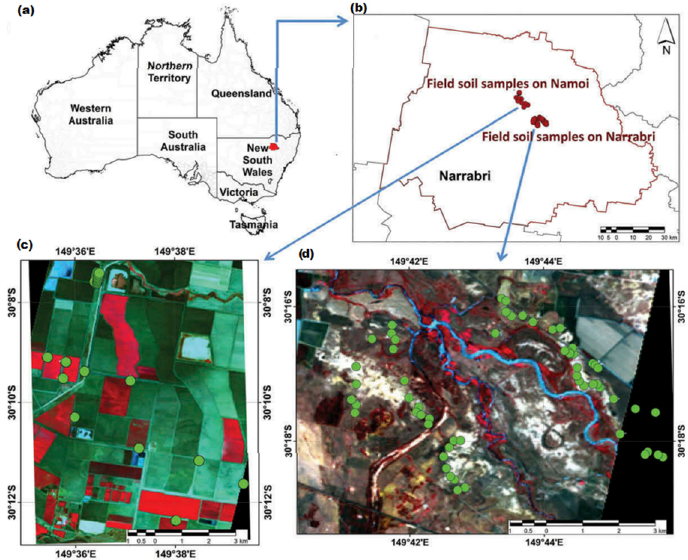
Figure 1. Location of the study area ( a ) in Australia, ( b ) on the Narrabri region; hyperion image acquired over ( c ) the site#1 and ( d ) site#2 with sampling points plotted in red dots.